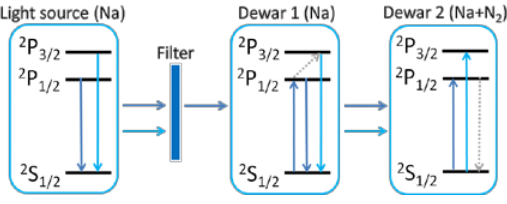
Figure 1. Pringsheim’s experiment.